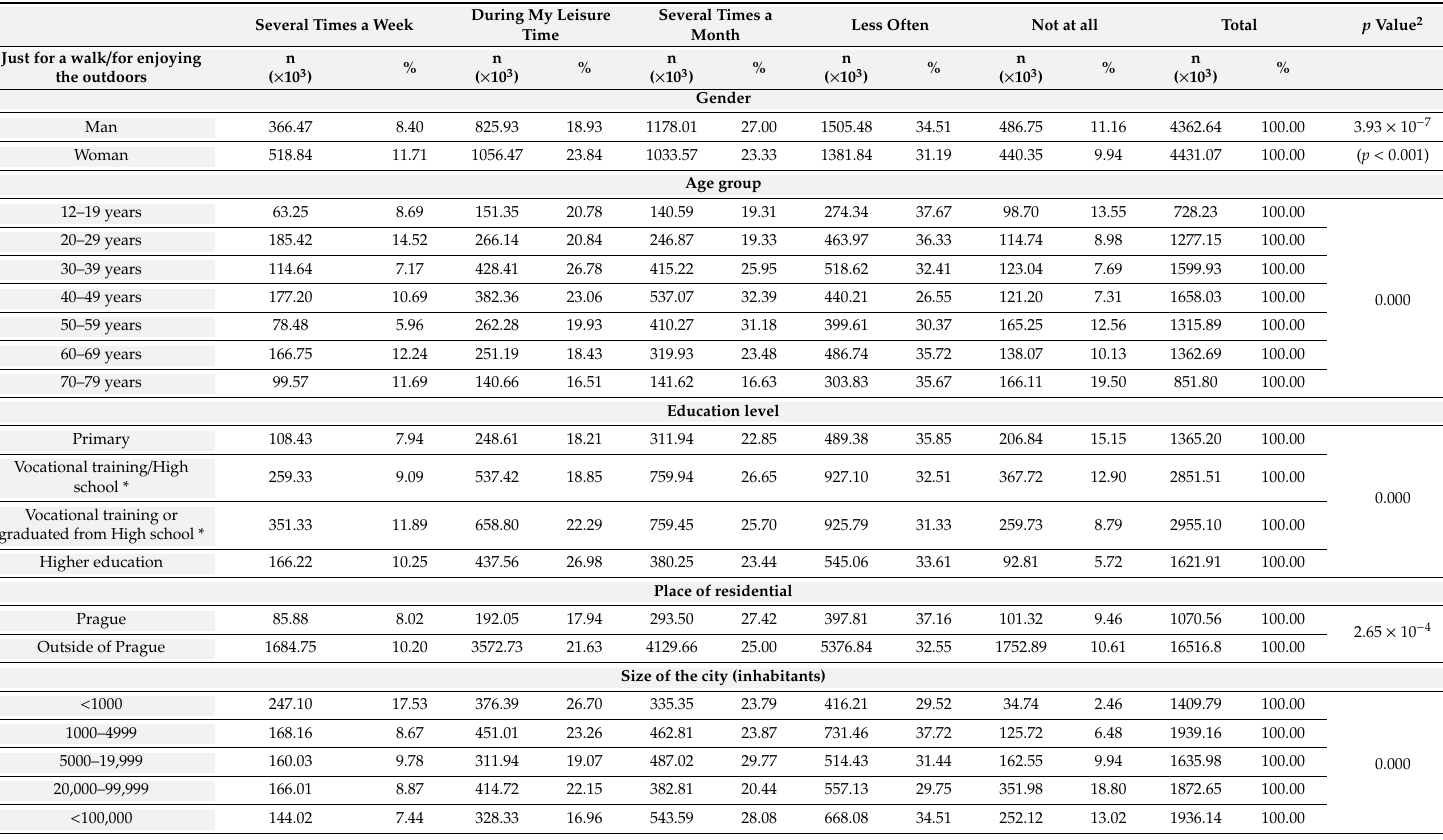
Table A1. Going on walks as a driver of the frequency of the forest visit in a year in the Czech Republic. Several Times a Week During My Leisure Time Several Times a Month Less Often Not at all Total p Value 2 Just for a walk / for enjoying the